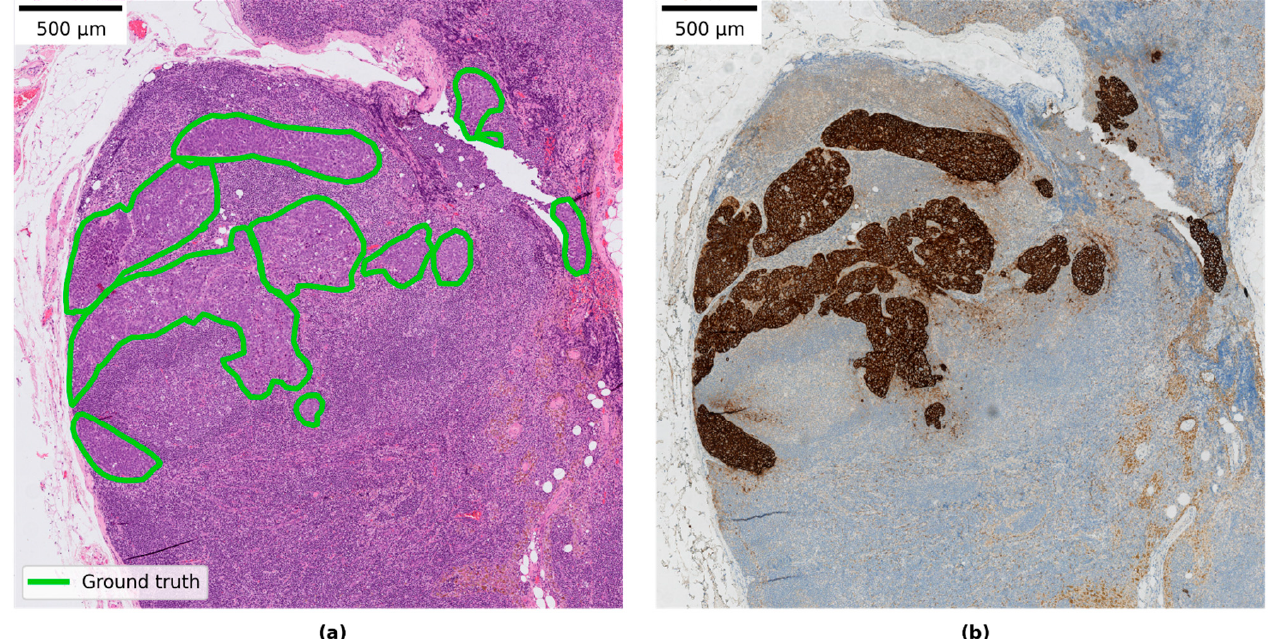
Figure 1. ( a ) Example of annotation of metastasis on an H&E slide. ( b ) Example of corresponding immunohistochemical stained slide for cytokeratin (CK AE1/AE3).